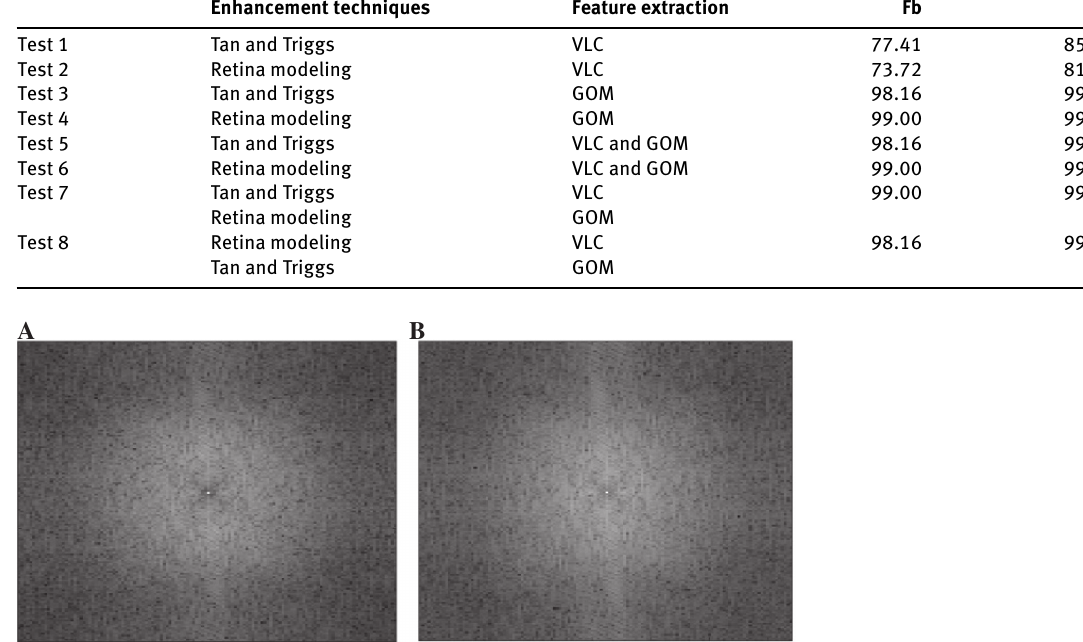
Figure 12: Image Spectrum Using (A) Tan and Triggs, (B) Retina